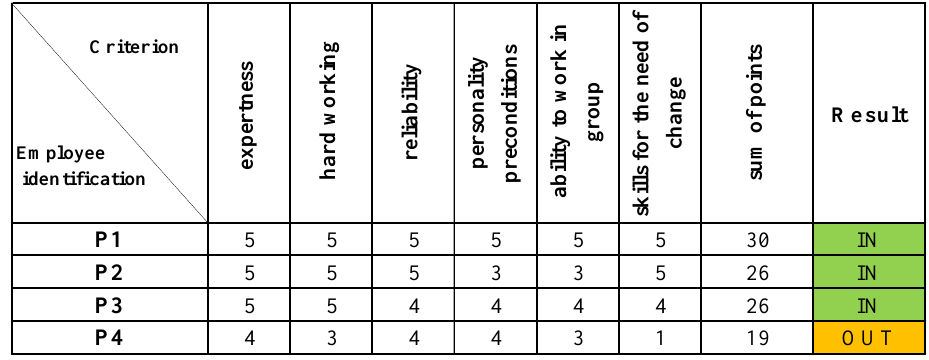
Table 6 – Evaluation of criteria by Head of operation